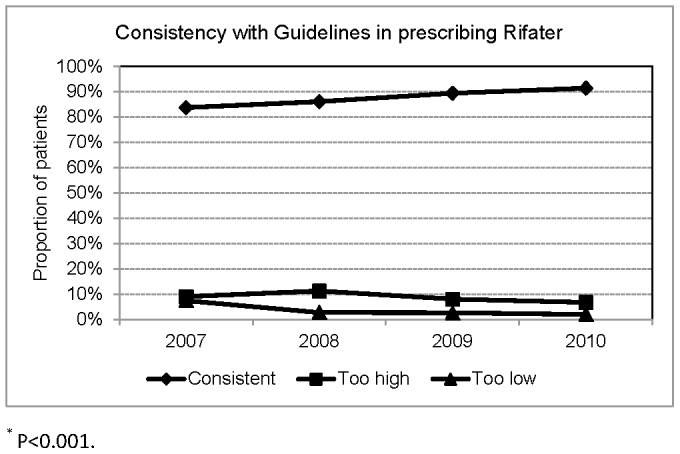
Consistency with Taiwan Guidelines in prescribing Rifater.